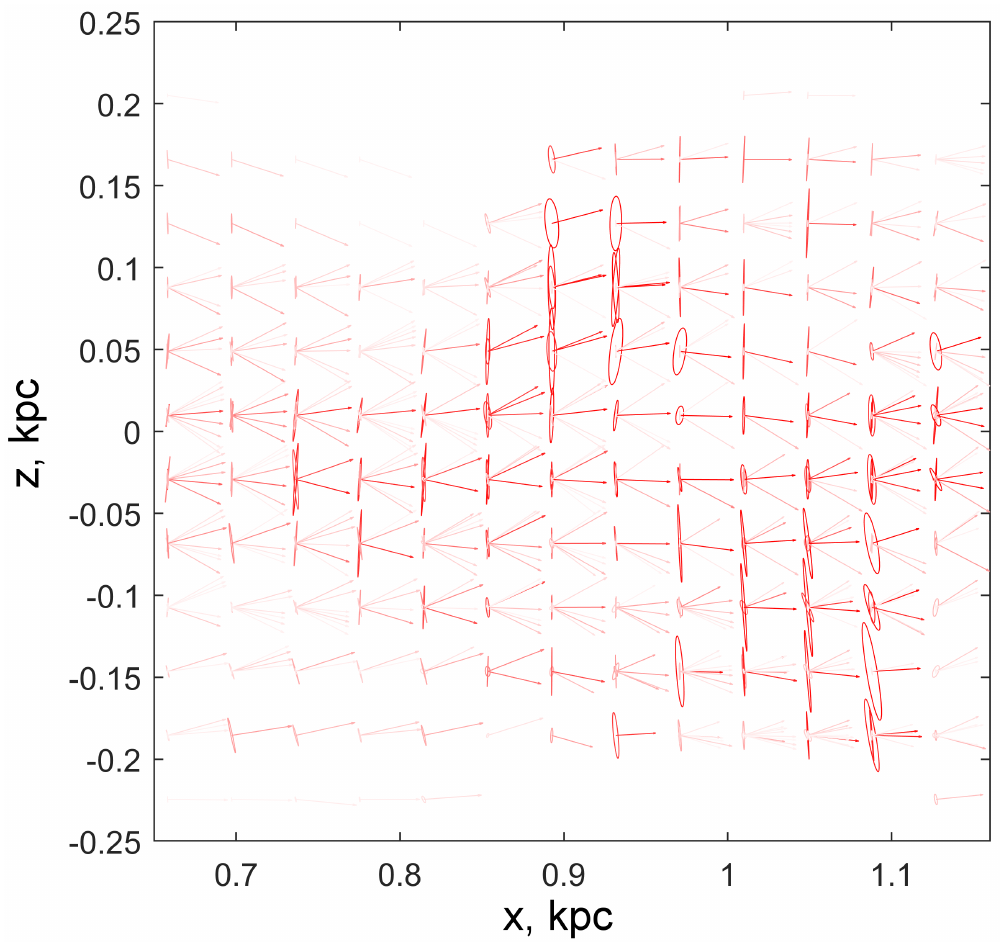
Figure 8. Fragment of the field of composite glyphs for beams of a large fraction of particles. All glyphs are built for areas of 0.024 × 0.024 kpc (6 × 6 cells). Each beam corresponds to a pair of objects in the glyph, an arrow and an ellipse. Arrow parameters and glyph colors are defined similarly to Figure 7. The ellipse determines the spread of the particle velocities in the beam: the semi-major axes are proportional to the standard deviations, and the directions of the ellipse axes are set by the principal axes of the